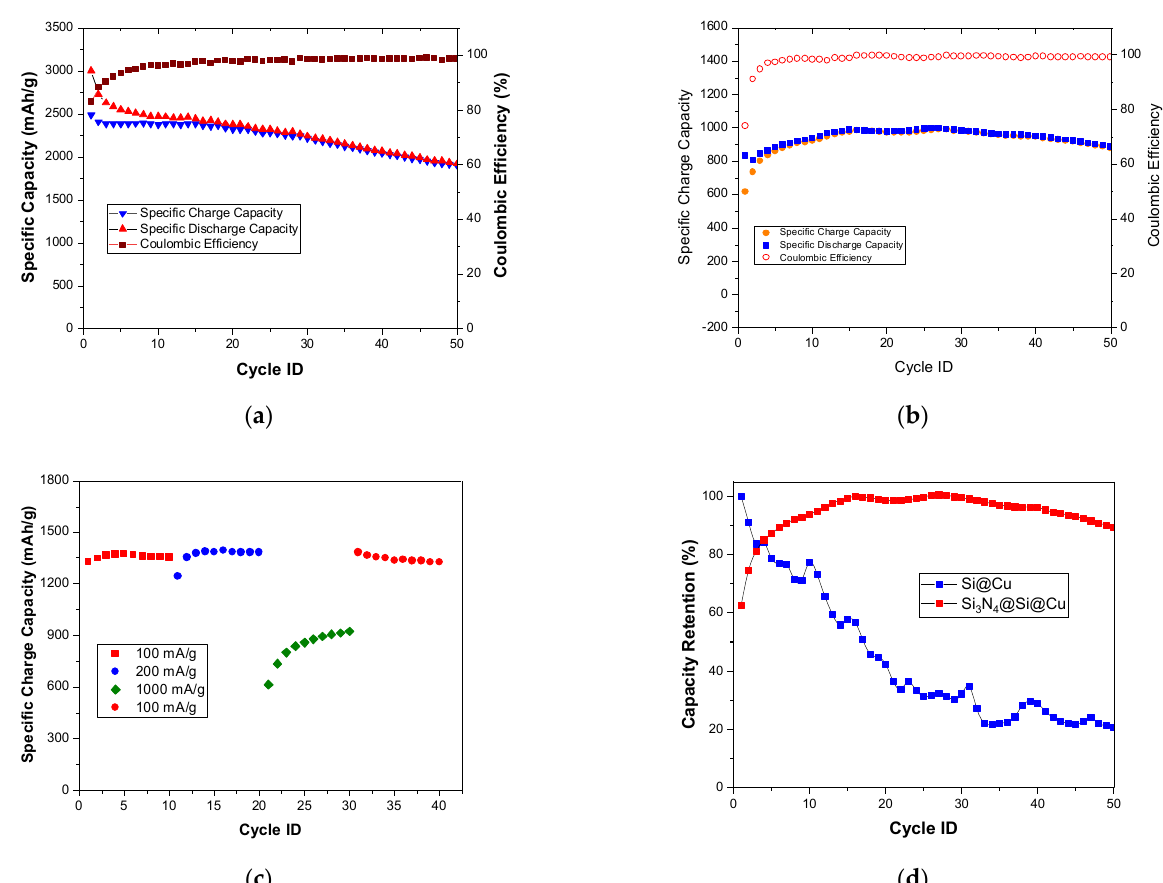
Figure 11. Cycling stability of Si 3 N 4 @Si@Cu in a half cell at ( a ) 20 mA/g and ( b ) 1000 mA/g. ( c ) Effect of capacity rate on performance (consecutive GCD). ( d ) Capacity retention of Si 3 N 4 @Si@Cu in comparison with Si@Cu.